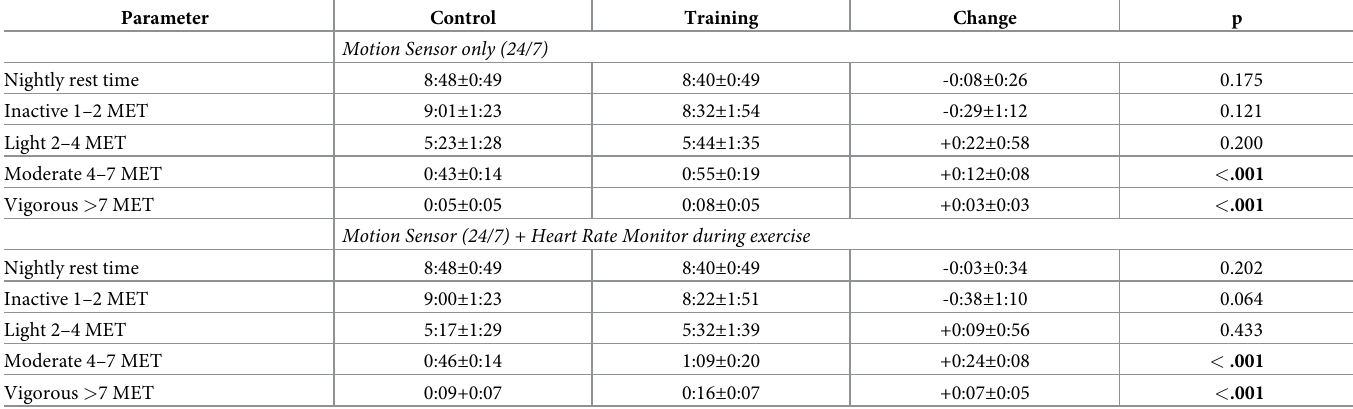
Table 5. Daily accumulated time (h:mm, mean ± SD) at different intensities of physical activity as detected by wearable devices during the control and training peri- ods, and their corresponding change.